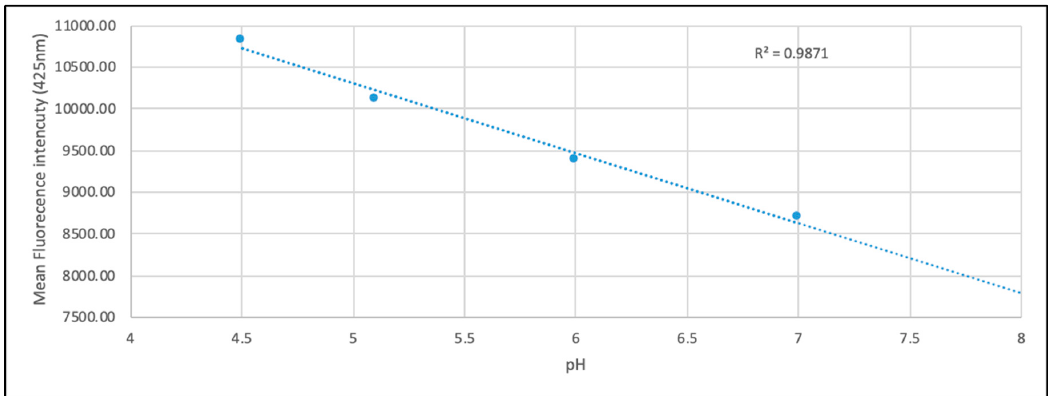
Figure 5. Standard pH curve from LysoSensor DND-167 after treatment of cells with standard pH solutions. Represents the mean fluorescence of all pH calibration data. n = 8 (for each calibrant). Data available in supplemental data under Table S5.